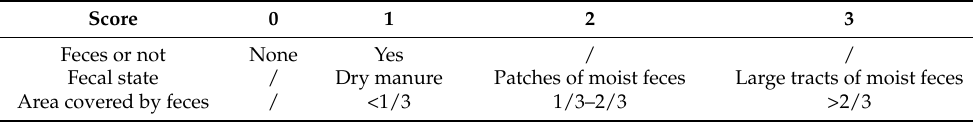
Table 1. Scoring standards for cleanliness of each area.